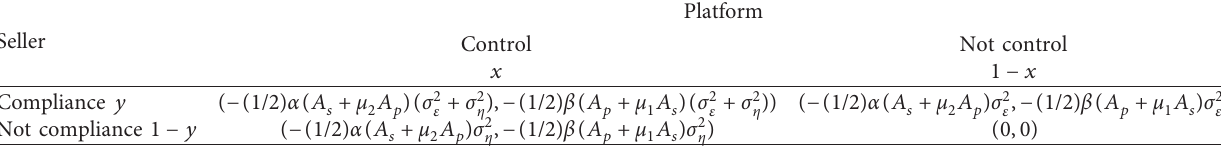
Table 4: The risk payoff